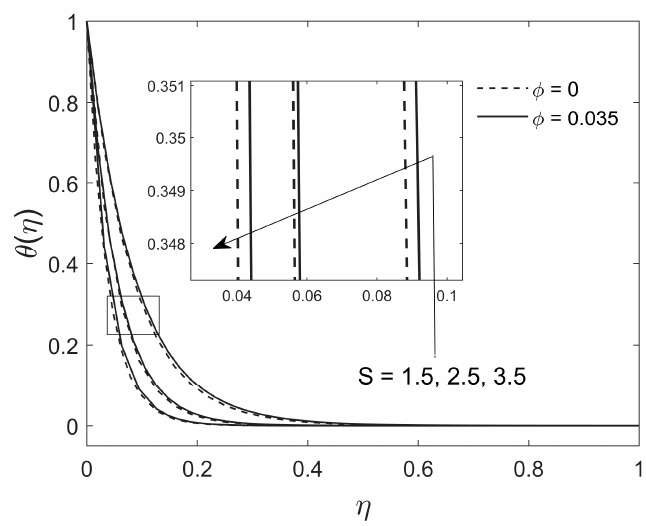
Figure 11. Effect of suction on the temperature distribution.